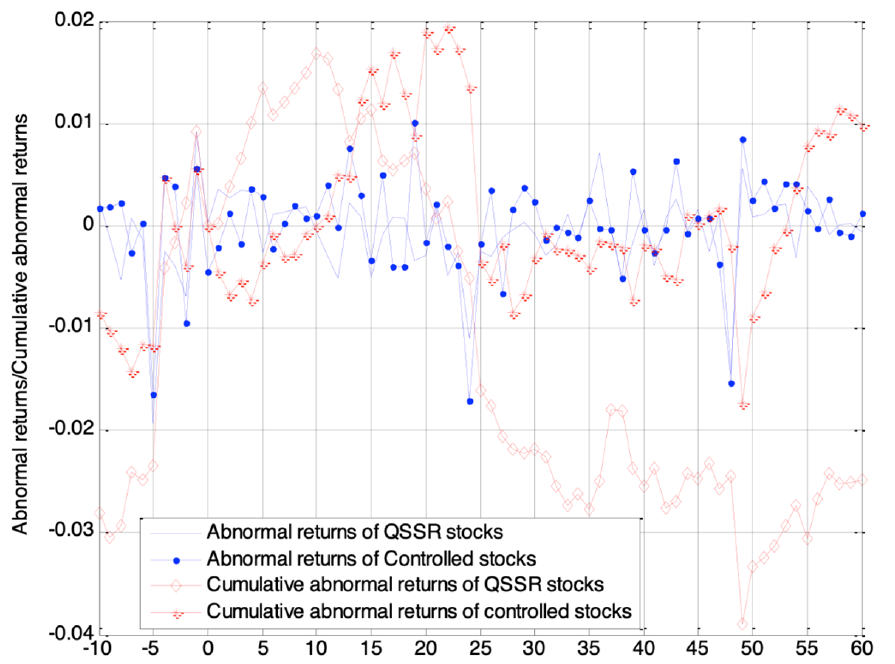
Figure 2. Mean abnormal returns (ARs) and cumulative abnormal returns (CARs) around 2nd addition to the QSSR